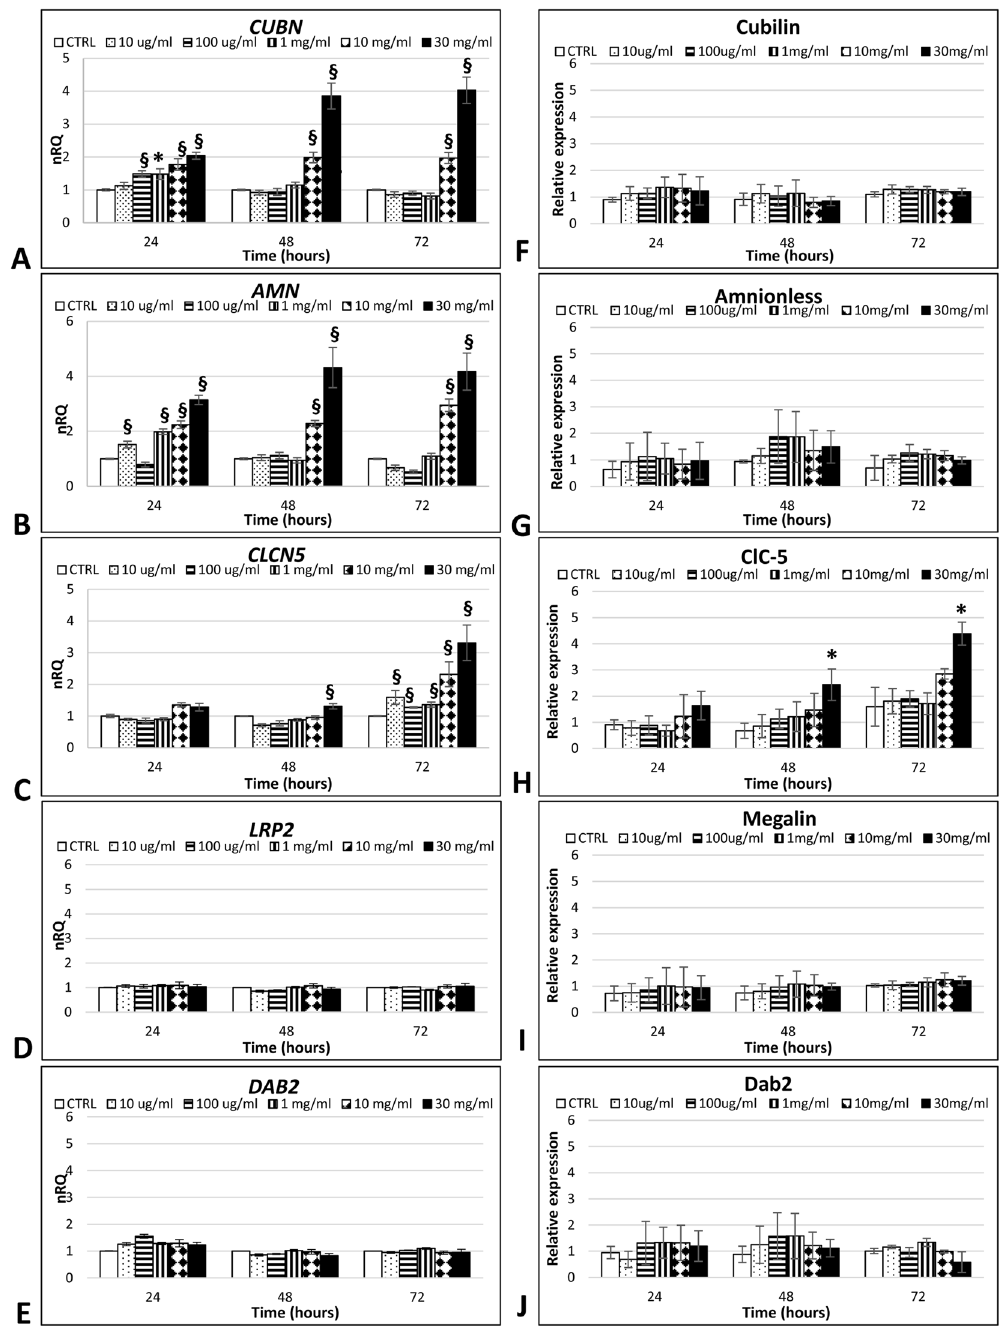
Figure 4. Protein overload modulates the expression of the CUBAM complex. Gene expression analysis of the macromolecular system showed an increase in CUBN ( A ), AMN ( B )and CLCN5 ( C ) genes. Data are given as the geometrical average ± SE of three independent experiments in duplicate. nRQ: normalized Relative Quantity. Protein expression analysis of the macromolecular system only showed an increase in ClC-5 ( H ) expression at the longest time and highest dose considered. Data are given as the average ± SD of four different experiments. CTRL: control cells, * P < 0.05, § P <